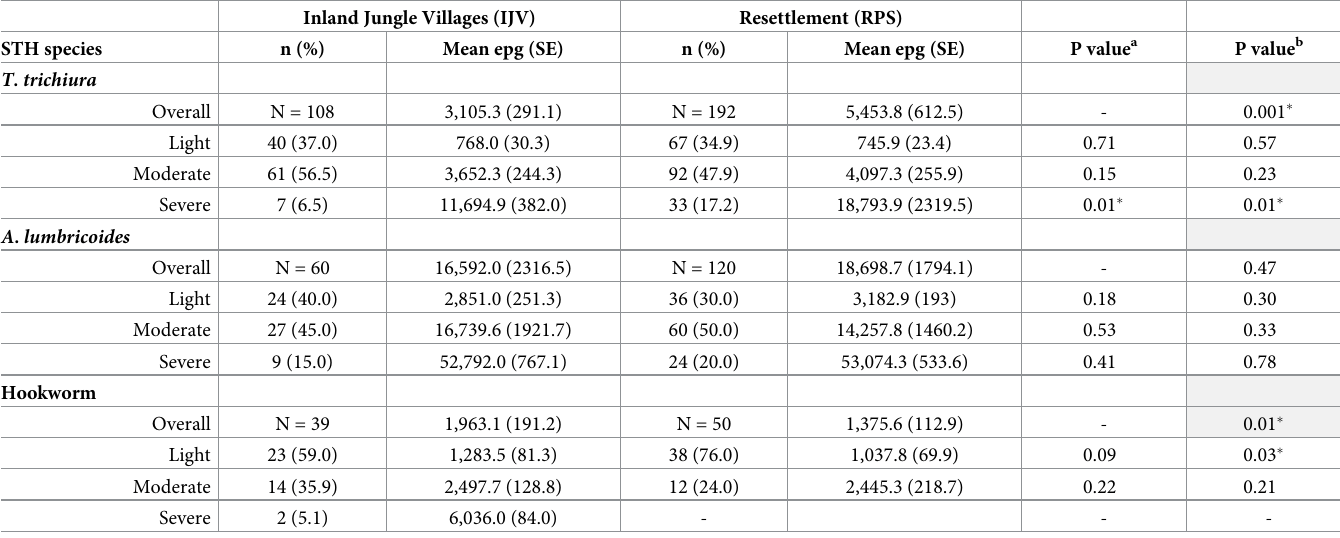
Table 4. Intensity of STH infections among the Negritos in Peninsular Malaysia according to STH species and comparison between communities (IJV versus RPS). Inland Jungle Villages